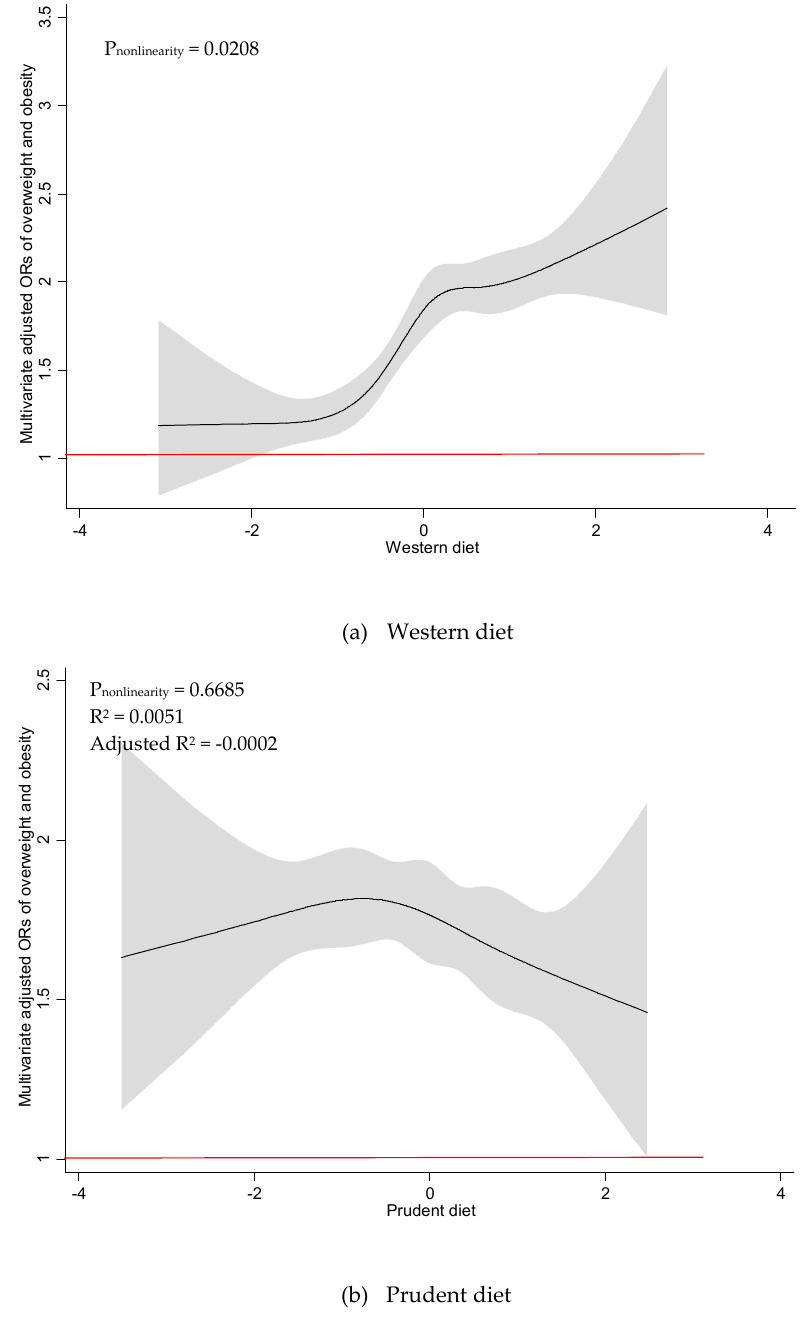
Figure 3. Restricted cubic spline plots between dietary patterns and multivariate adjusted odds ratio of overweight and obesity among all men. ( a ) Western diet and ( b ) Prudent diet. Results obtained by multivariable logistic regression with restricted cubic splines with five knots. Solid black lines indicate odds ratio, and shaded areas indicate 95% CI.